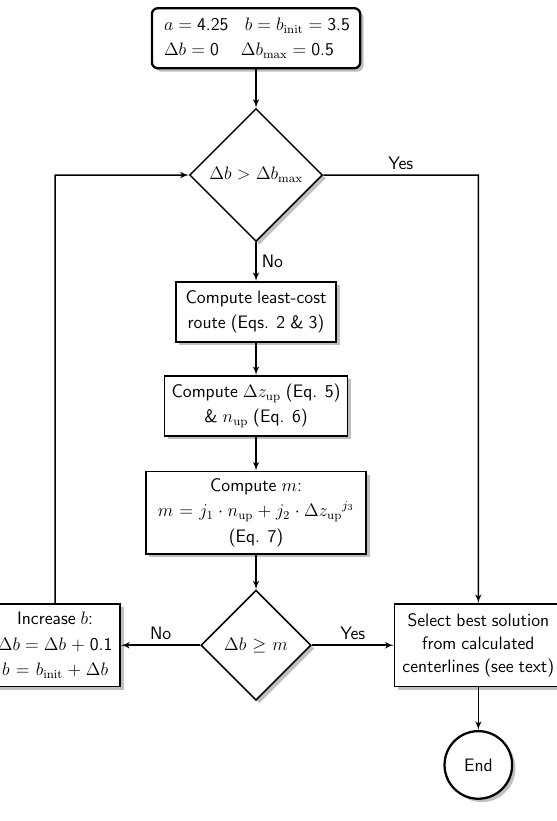
Fig. 6. Flow chart illustrating the optimization steps, including im- portant equations and parameter values. Rectangles show the main operations, while diamonds represent decisions.